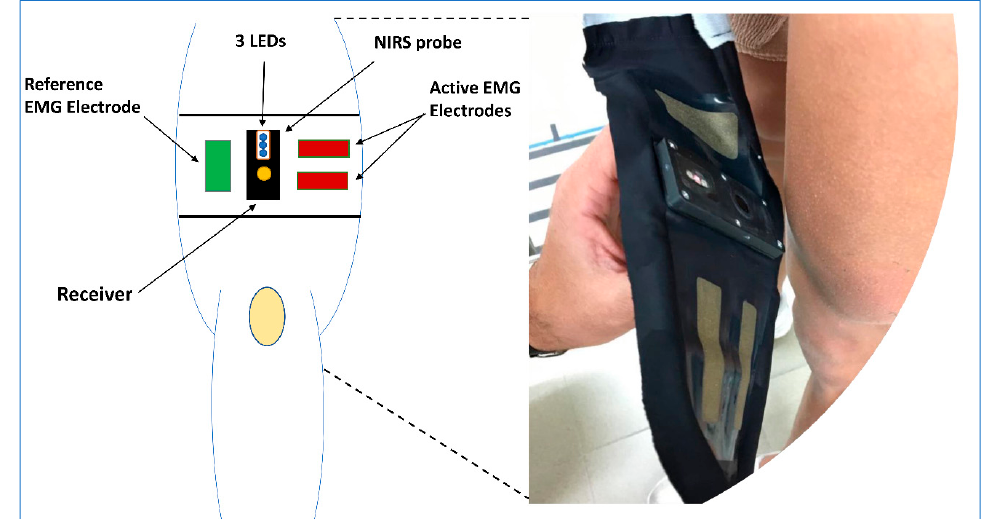
Figure 1. Details of the integrated system (wiNIREM) developed by Ohmatex ApS, including the fabric-based thigh wearable EMG sensors and the NIRS-oximetry probe. Scale